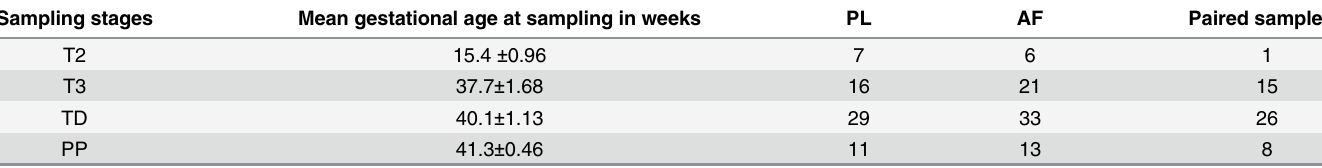
Table 1. The characterization of the amniotic fluid and plasma